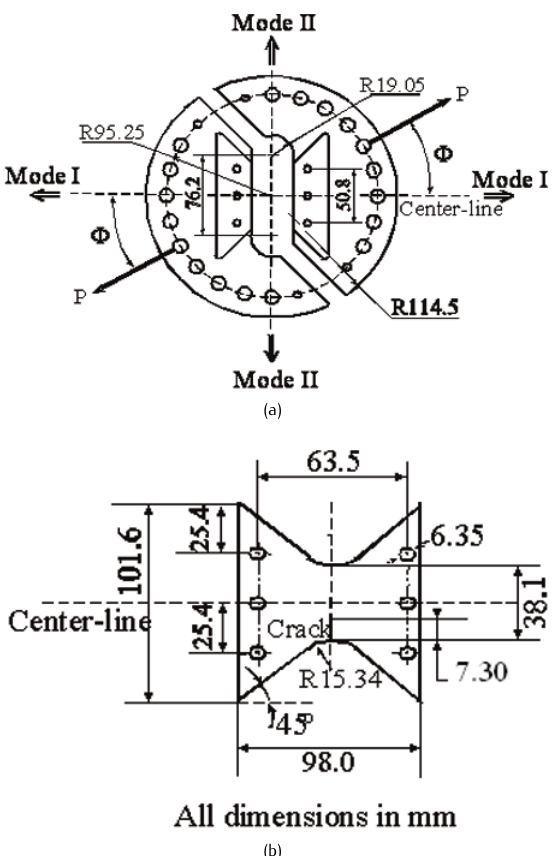
Figure 1 In-plane geometry of the Arcan fixture and the specimen: (a) the fixture; (b) the specimen.